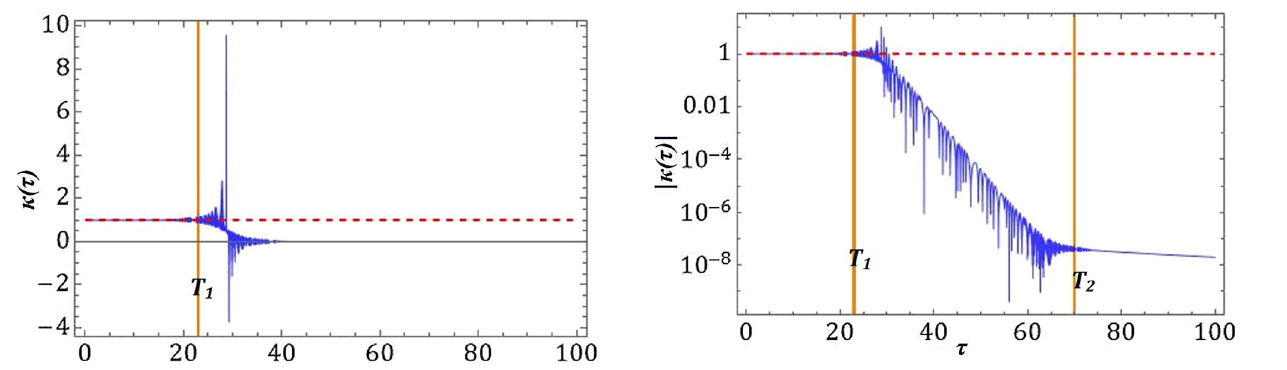
Fig. 6 The modulus of the results presented in Fig. 5 in the logarith- mic scale. The solid line: | κ(τ) | = | ( E (τ) − E min )/( E 0 − E min ) | ≡ | (Λ( t ) − Λ )/(Λ − Λ ) | . The dashed line: E (τ) = E bare bare 0 const, or, Λ(τ) = Λ 0 = const, ( κ(τ) = 1). The time, t , is measured in lifetimes τ 0 : τ = t /τ 0 and τ 0 = ¯ h /Γ 0 is the lifetime = const, 0